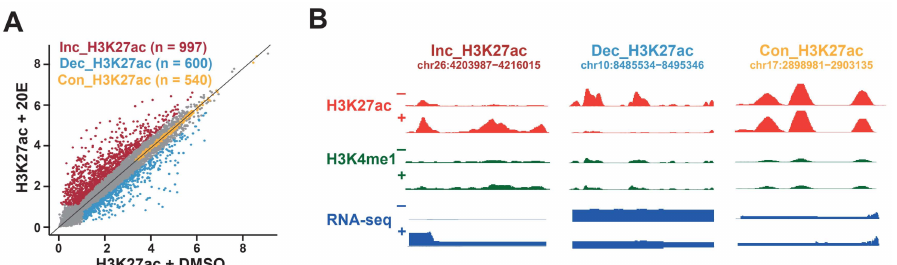
Figure 3. Enhancers were categorized based on changes in H3K27 acetylation. ( A ) Enhancer cat- egorization based on H3K27 acetylation signals in response to 20E treatment. H3K27 acetylation signals were taken from the normalized H3K27 acetylation ChIP-seq reads within a 1.5 kb window centered on each enhancer. Inc, increasing; Con, constant; Dec, decreasing. ( B ) IGV genome browser screenshots of ChIP-seq and RNA-seq tracks for representative loci demonstrating distinct H3K27 acetylation dynamics at enhancers in response to 20E treatment. + and − indicate the presence or absence of 20E treatment,